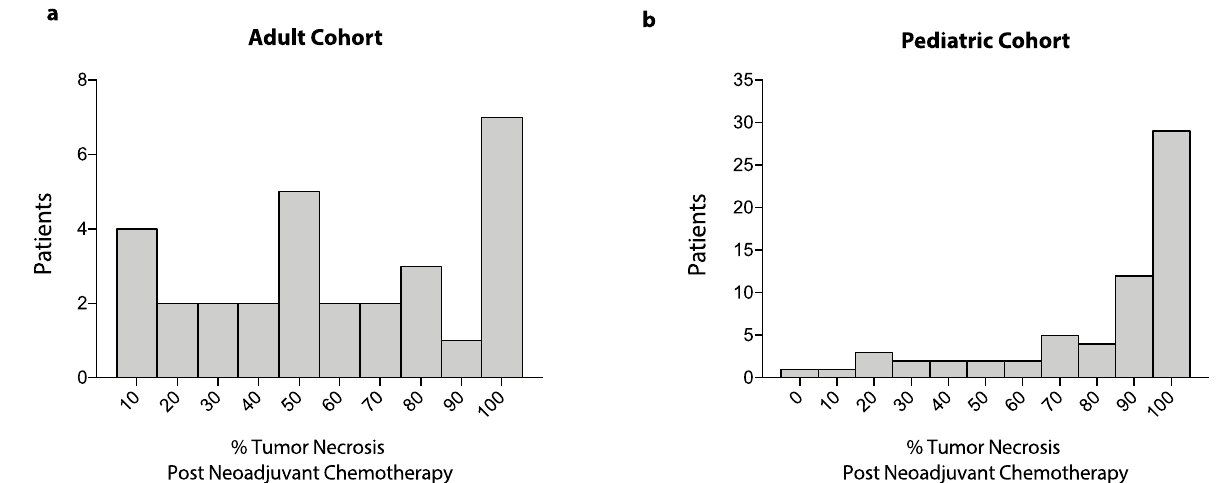
Figure 2. Frequency distribution of tumor necrosis after neoadjuvant chemotherapy. Data show frequency distribution of percent tumor necrosis after neoadjuvant chemotherapy for patients in the adult cohort ( a ) and patients in the pediatric cohort ( b ).